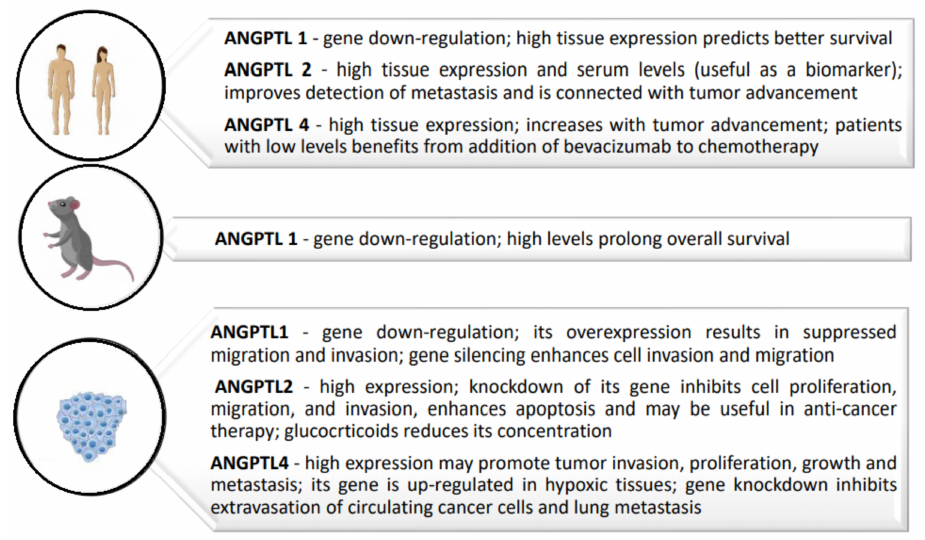
Figure 3. Summary of the most important data concerning angiopoietin-like proteins in colorectal cancer divided into human, mouse, and cell culture